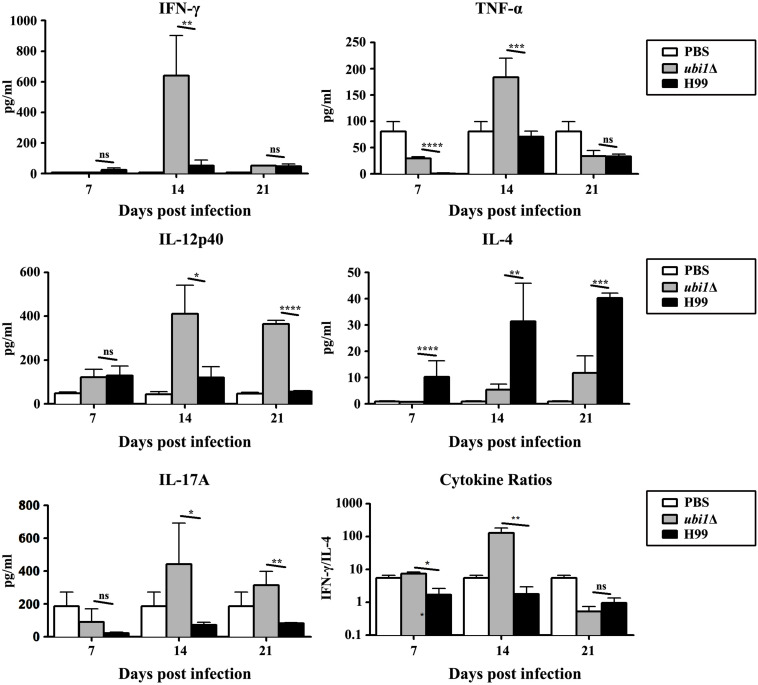
UBI1 deletion induced the robust development of pulmonary Th1 cytokine bias during cryptococcal infection. Specified inflammatory cytokines of C. neoformans-infected mice were analyzed using ELISA. Results represent mean ± SEM, N = 4 or more mice per group. *P < 0.05, **P < 0.01, ***P < 0.001, ****P < 0.0001; ns, no significant difference.